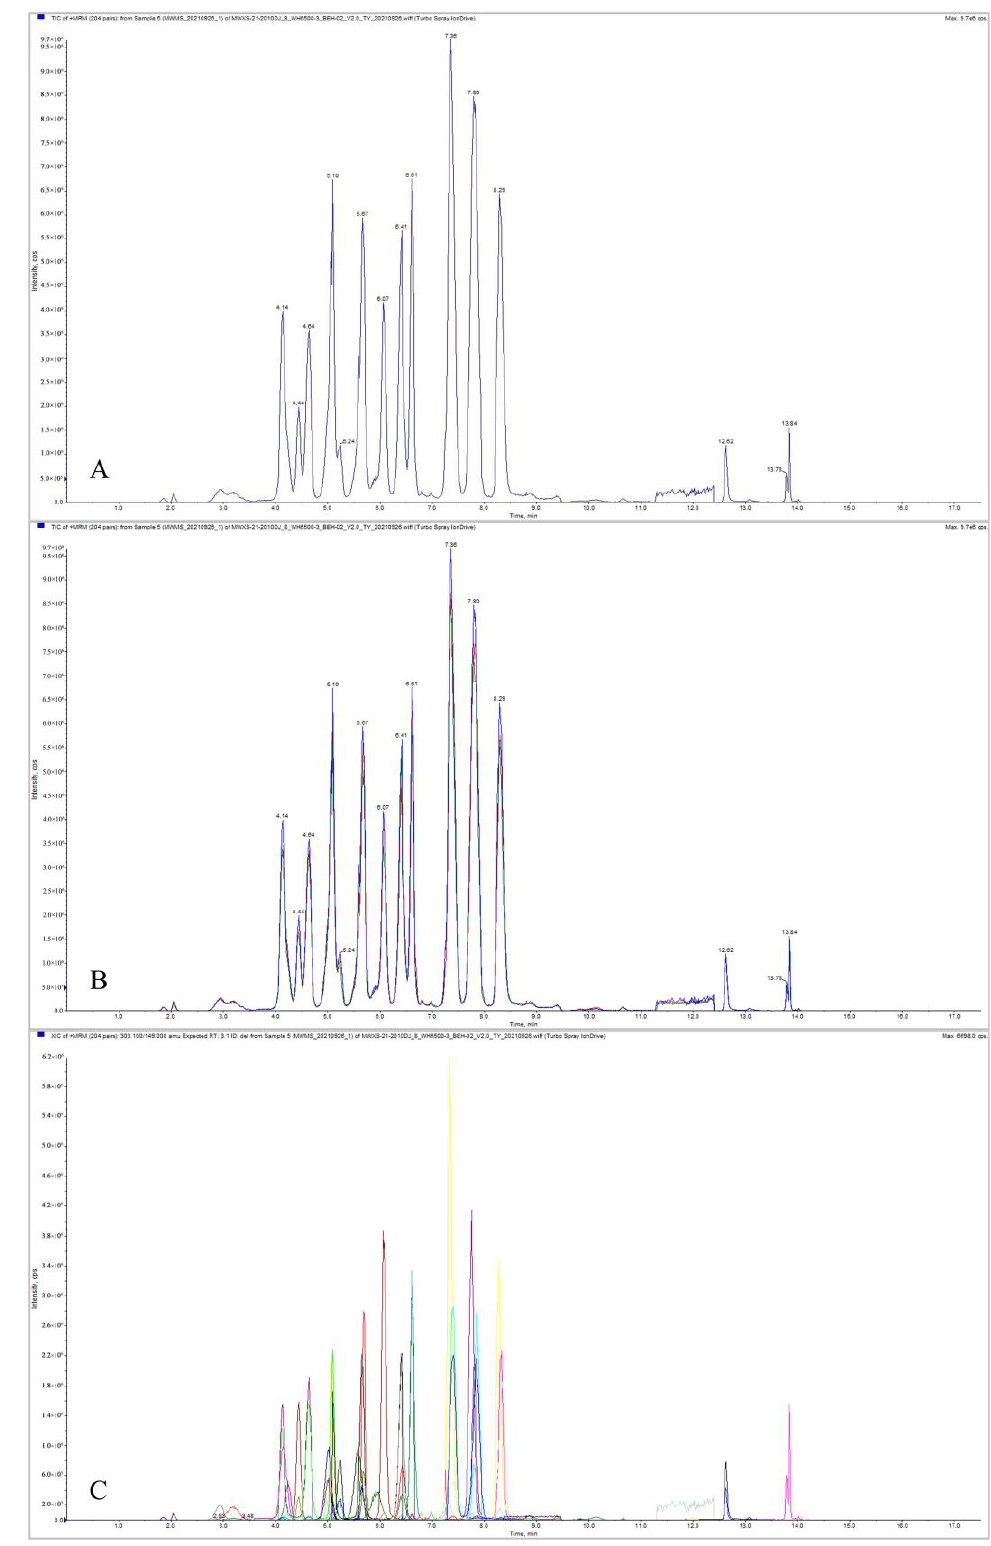
Figure 5. Total ion current diagram for quality control sample by mass spectrometry ( A ), and total ion current overlaps for quality control sample by mass spectrometry ( B ); multi-peak detection plot of metabolites by MRM metabolite ( C ).